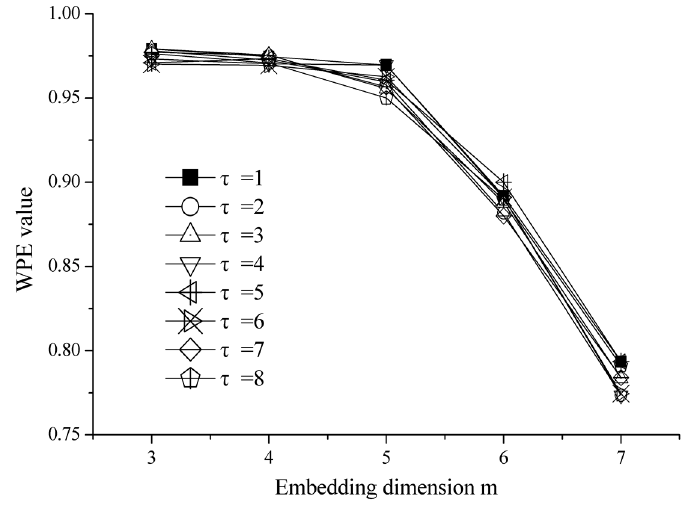
Figure 2. The effect of embedding dimension m and time lag τ on the Weighted Permutation Entropy (WPE) value.